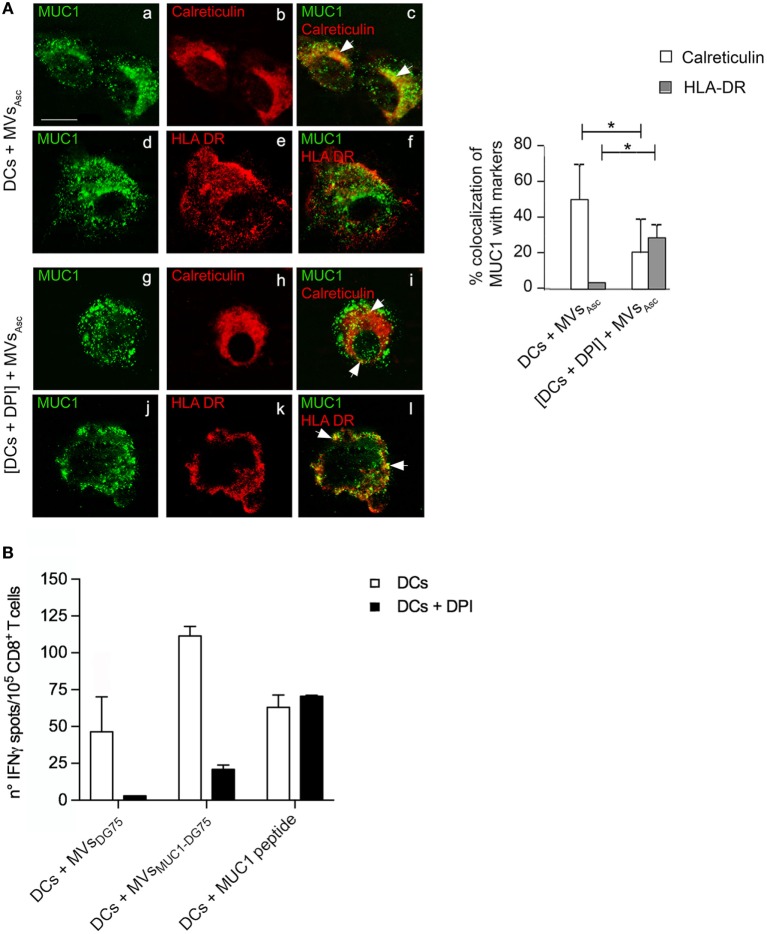
Tumor microvesicles (MVs) induce MUC1 processing to HLAI in dendritic cells (DCs) with acid phagosomal compartment, while cross-presentation of MUC1 antigen requires functional DCs. (A) Intracellular localization of MUC1 carried by MVsAsc in DCs (a–f) and in diphenyleneiodonium chloride (DPI)-treated DCs (g–l) was visualized by immunofluorescence staining after 12 h of internalization employing the anti-MUC1 MoAb Ma552 (green, a, d, g, j) and antibodies direct against specific markers for intracellular compartments (red). In particular: anti-calreticulin rabbit polyclonal antibody for ER (b, c, h, i) and anti-HLAII-DR for HLA-II compartment (e, f, k, l). Colocalization of the green and red immunofluorescence signals is shown in yellow (c, f, i, l). Quantitative analysis of colocalization was calculated as reported in material and methods and plotted as histograms. Results are expressed as mean values ± SD. Student’s t-test was performed and significance level has been defined as p < 0.05. *p < 0.05. Bar: 10 µm. (B) ELISpot assay to evaluate the IFNγ cytokine secretion by MUC1-specific enriched CD8+ T cells from an ovarian cancer patient in response to mDCs (white histograms) and mDCs + DPI (black histograms) pulsed with MVsDG75, MVsMUC1-DG75 and MUC1(159-167) peptide. Results are shown as average and SD of replicates.